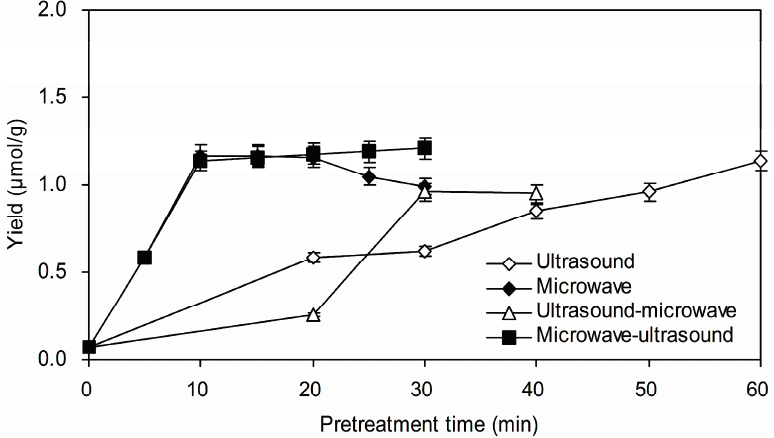
Figure 2. Effect of microwave, ultrasound or their combination irradiation method on yield of genipin. One gram degreased sample powder was added into 10 mL deionized water and homogeneous mixing prepared for pretreatment by microwave, ultrasound or their combination irradiation method. The ultrasound and microwave irradiation power were 250 W and 500 W, respectively. The samples were then mixed with 5.0 mg cellulase, and subsequently the mixtures were incubated at 40 °C for 24 h. After incubation, 10 mL ethanol was added to extract genipin over 30